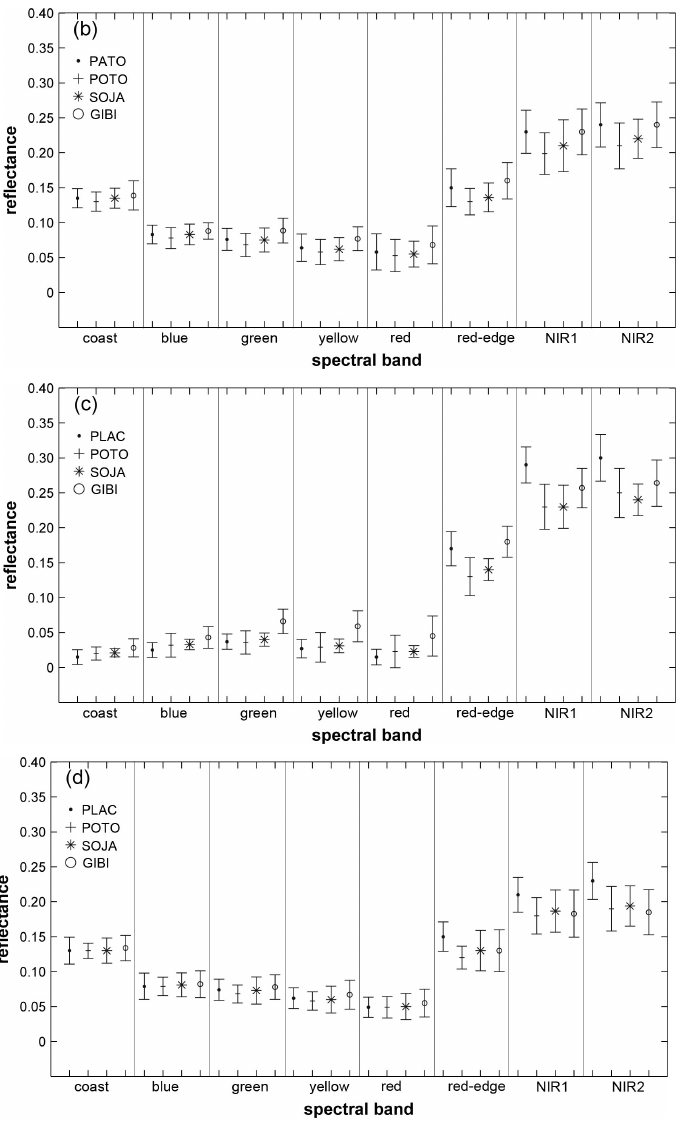
Figure 2. Mean spectral characteristic of the dominant tree species on ( a ) WV2 image over CNU study area; ( b ) WV3 image over CNU study area; ( c ) WV2 over BNU study area; and ( d ) WV3 over BNU study area.